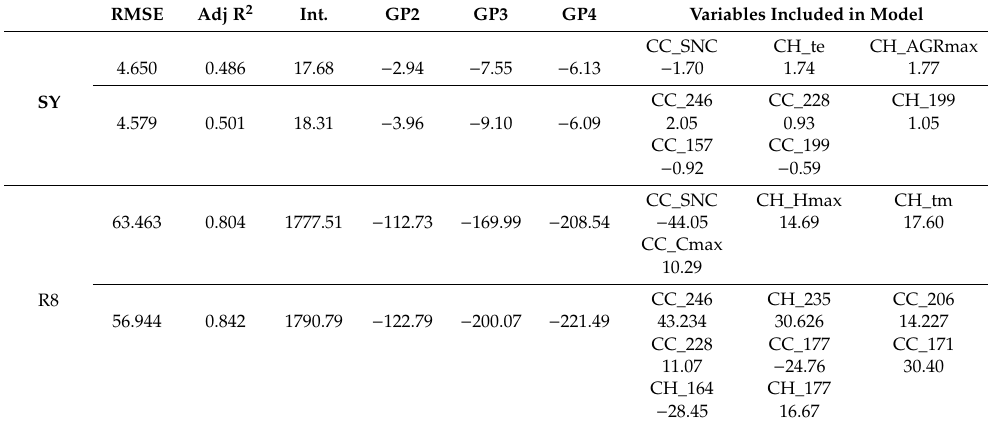
Table 4. Statistics and coe ffi cients of the normalized variables for the MLRs for seed yield (SY) and R8 stage based on the phenotypic parameters and the raw flight data. RMSE Adj R 2 Int. GP2 GP3